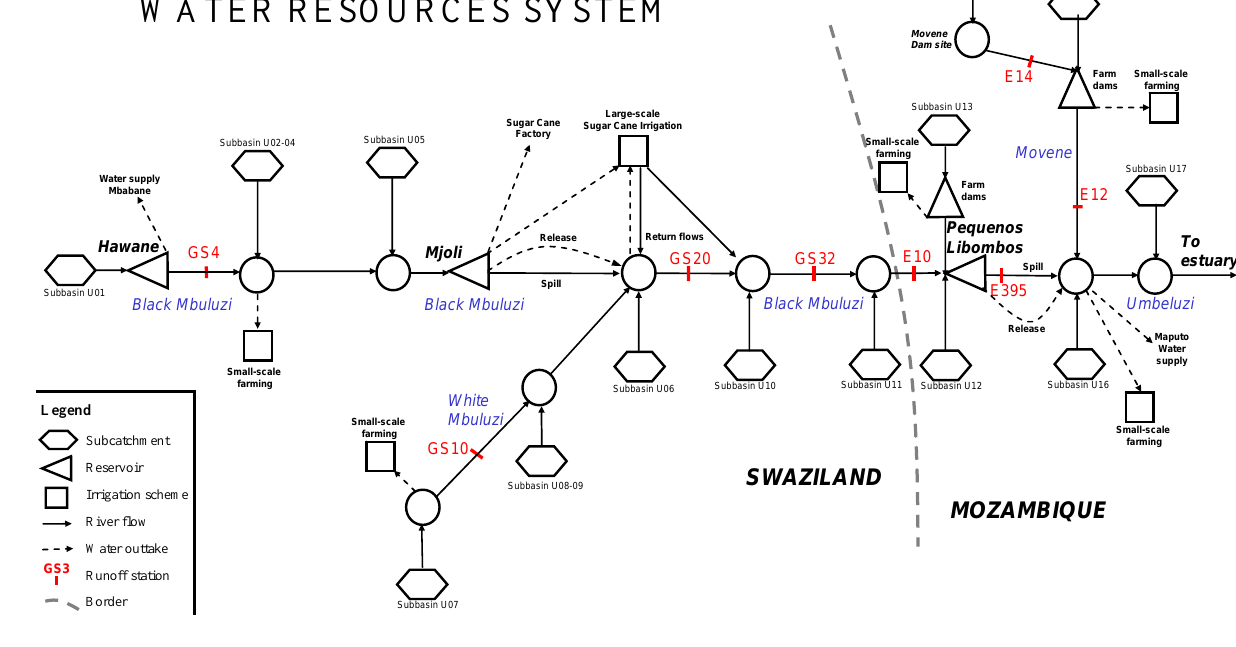
Figure 2 Simplified Umbeluzi River basin system model schematic Fig. 2. Simplified Umbeluzi River basin system model schematic.